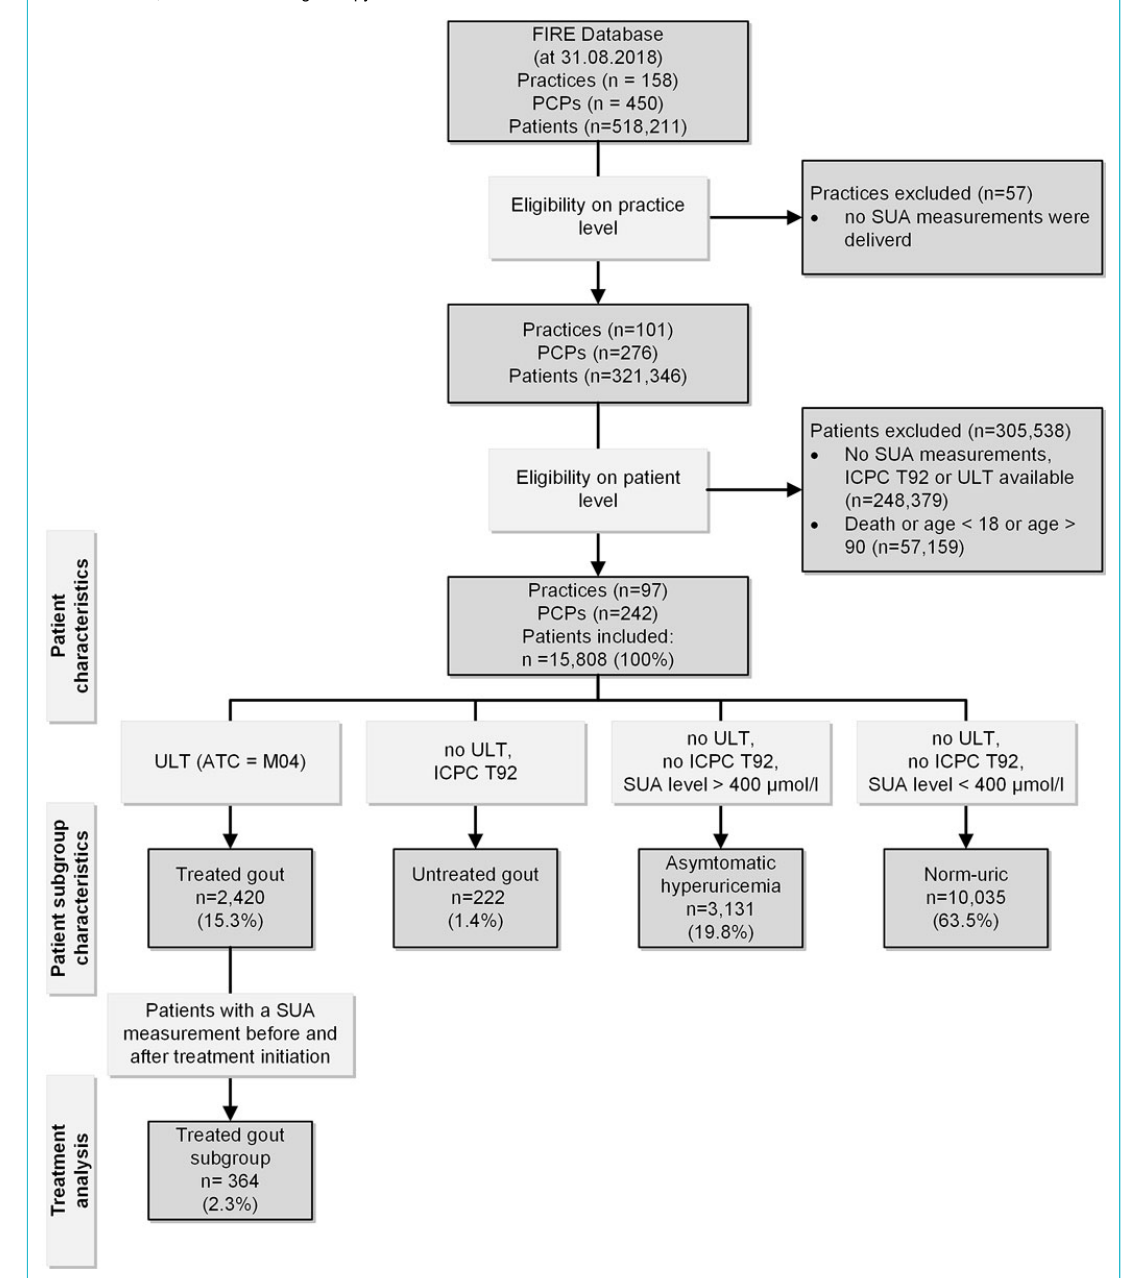
Figure 1: Flow chart of the study design and inclusion/exclusion criteria including number and proportions of patients. FIRE = family medicine ICPC Research using electronic medical records; ICPC = international classification of primary care; PCP = primary care physician; SUA